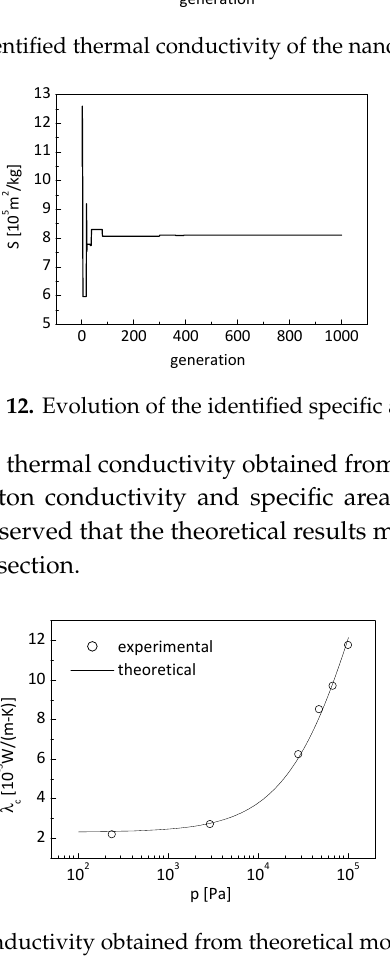
Figure 13. E ff ective thermal conductivity obtained from theoretical model based upon the identified Figure 13. Effective thermal conductivity obtained from theoretical model based upon the identified Figure 13. Effective thermal conductivity obtained from theoretical model based upon the identified Figure 13. Effective thermal conductivity obtained from theoretical model based upon the identified skeleton conductivity and specific skeleton conductivity and specific area. skeleton conductivity and specific area. skeleton conductivity and specific area.